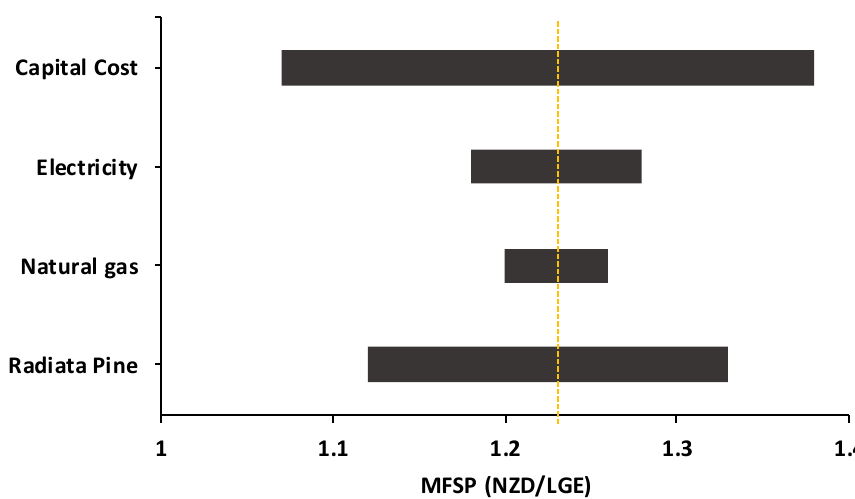
Figure 5. Sensitivity analysis of the change in materials and capital cost.